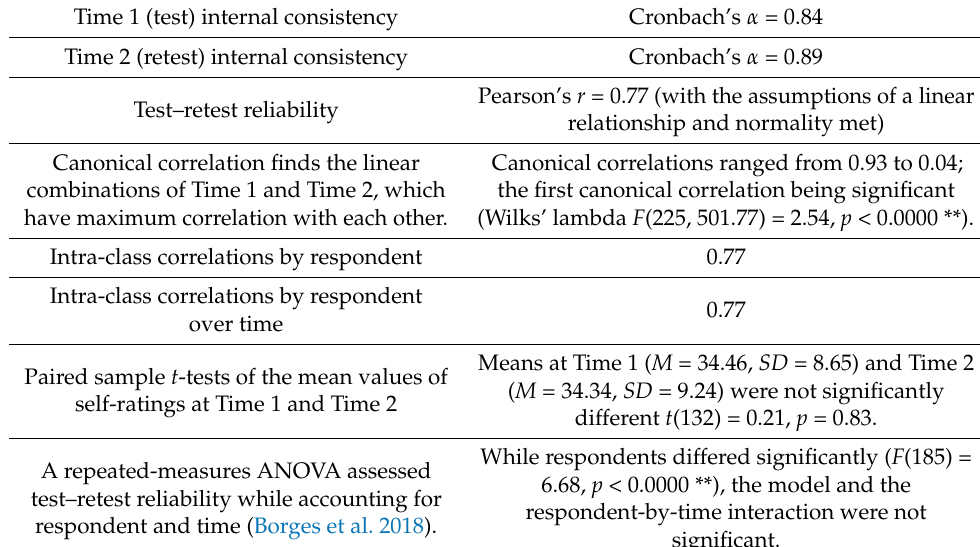
Table 1. Reliability